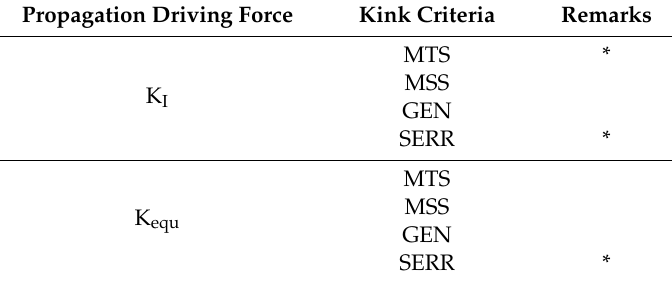
Table 3. Simulation